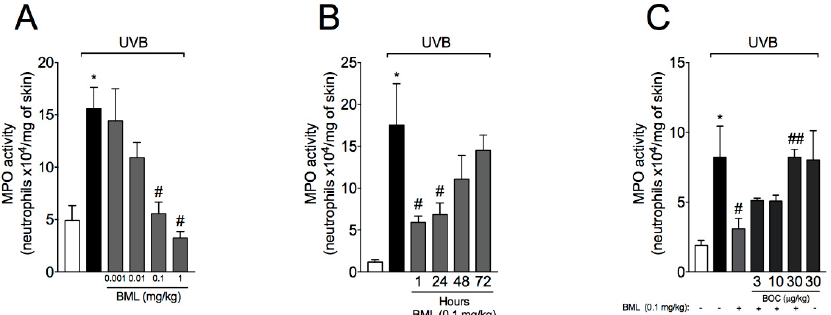
Figure 1. BML-111 reduces neutrophil recruitment in a dose-dependent manner and in an